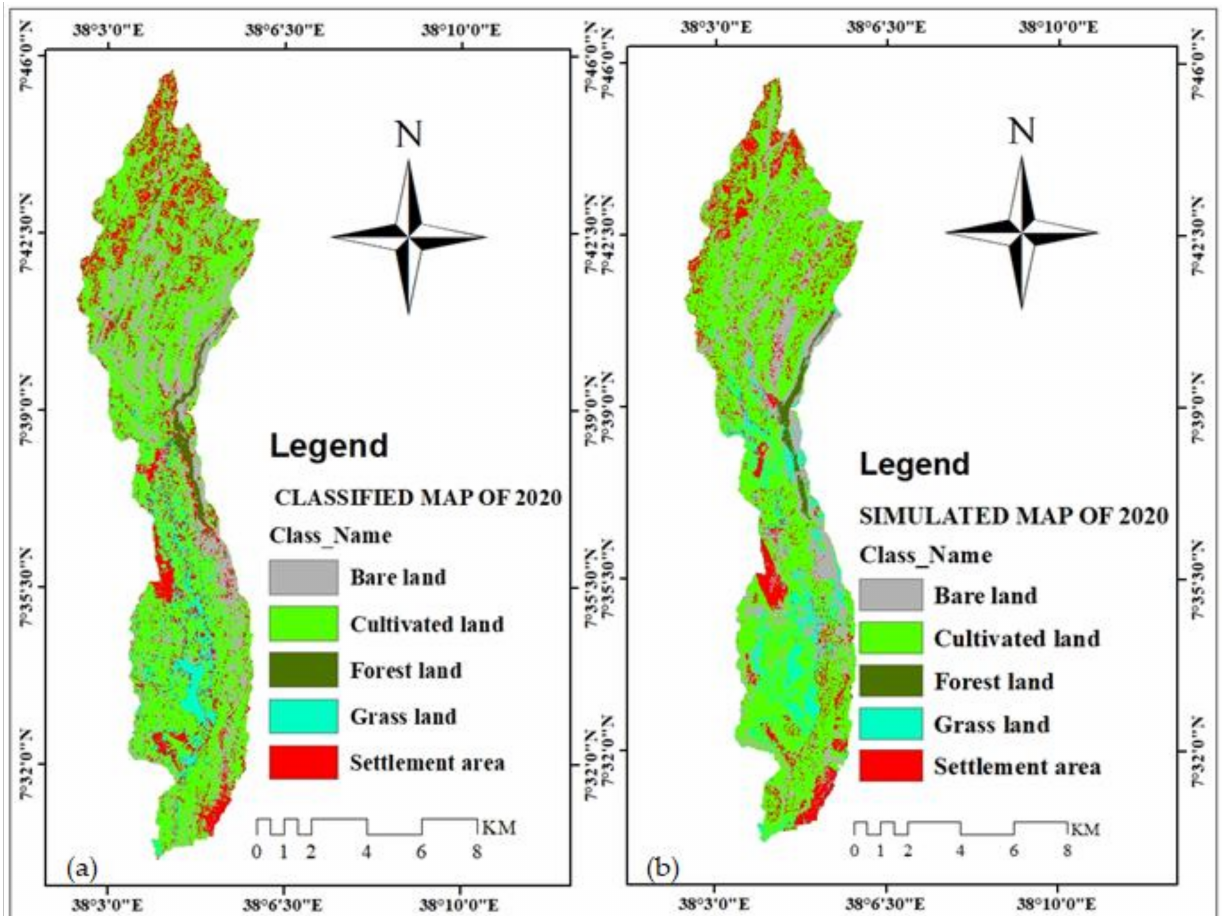
Figure 9. Matenchose Watershed LULC map of 2020, observed ( a ) and simulated ( b ).